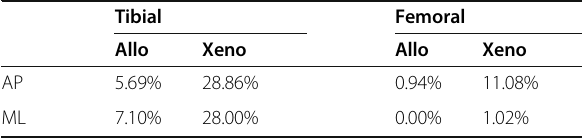
Table 7 X-ray Evaluation of Tunnel Changes (Increase in Tunnel Diameter, 12 Month versus 7 Day) - Missing/Contaminated Graft Subjects Included (LOCF)